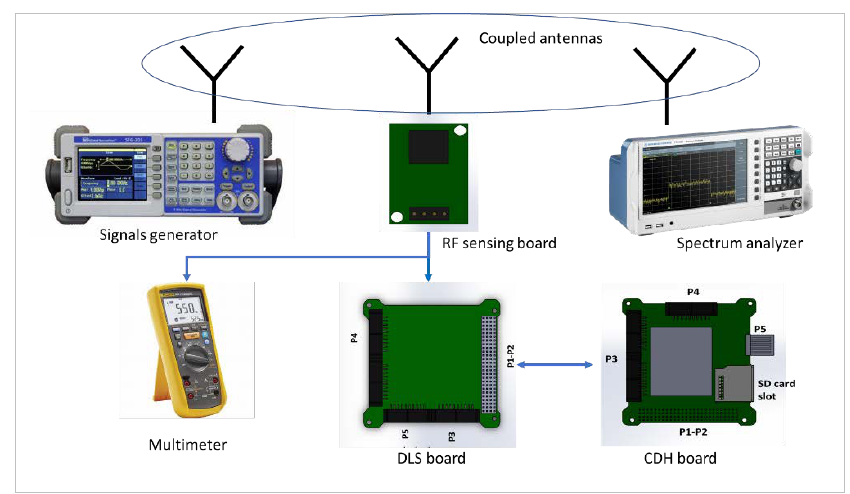
Figure 12. Setup for the calibration of the RF sensing circuits.